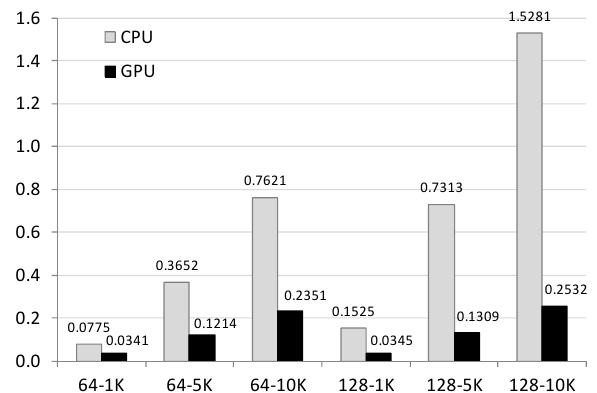
Figure 7. CPU and graphics processing unit (GPU) times (in ms) from Berlin130 with respect to different populations (64 and 128) and iterations (1000, 5000, and